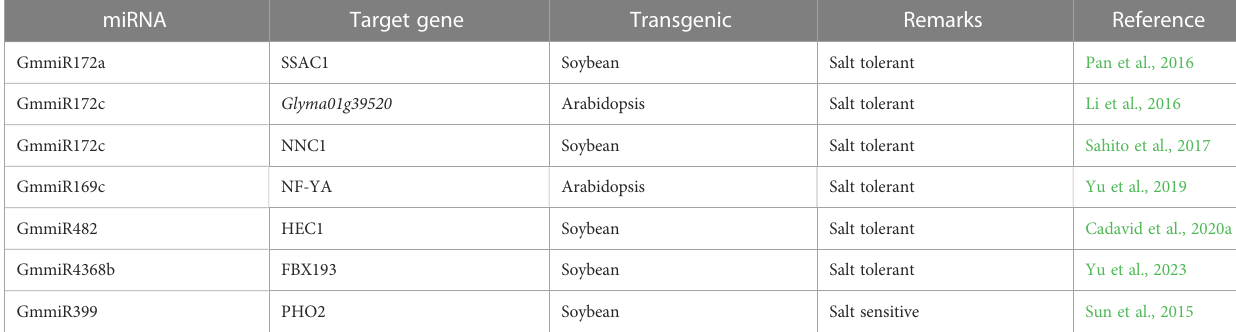
TABLE 3 List of Soybean miRNA for salt tolerance. miRNA Target gene Transgenic